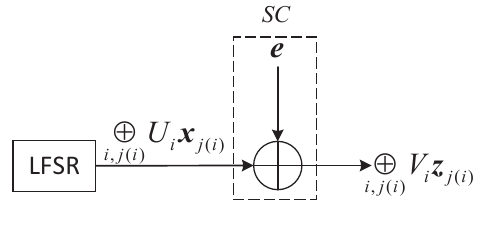
Figure 1: Channel model for